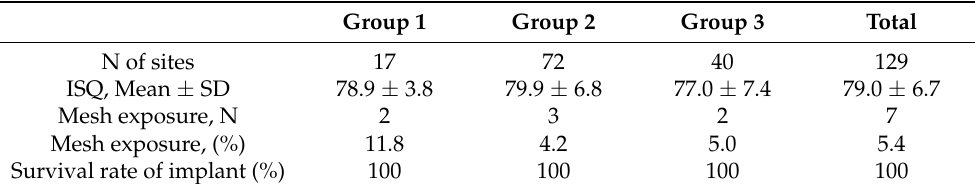
Table 2. Clinical evaluation of the ISQ value, mesh exposure, and survival rate of implants in the groups.